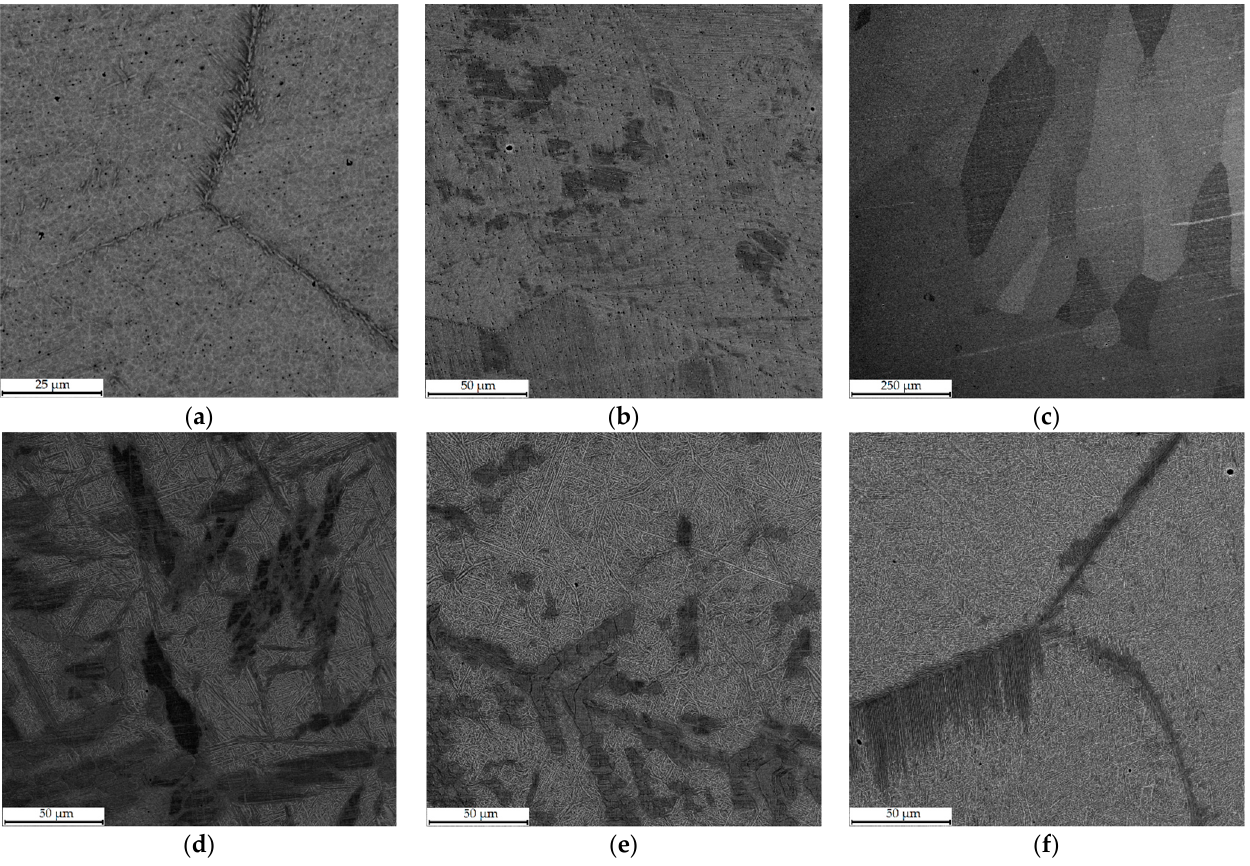
Figure 4. SEM-BSE images of as-printed samples microstructure: ( a – c ) for Alloy 1, 1–3 regimes, respectively; ( d – f ) for Alloy 2, 1–3 regimes, respectively.